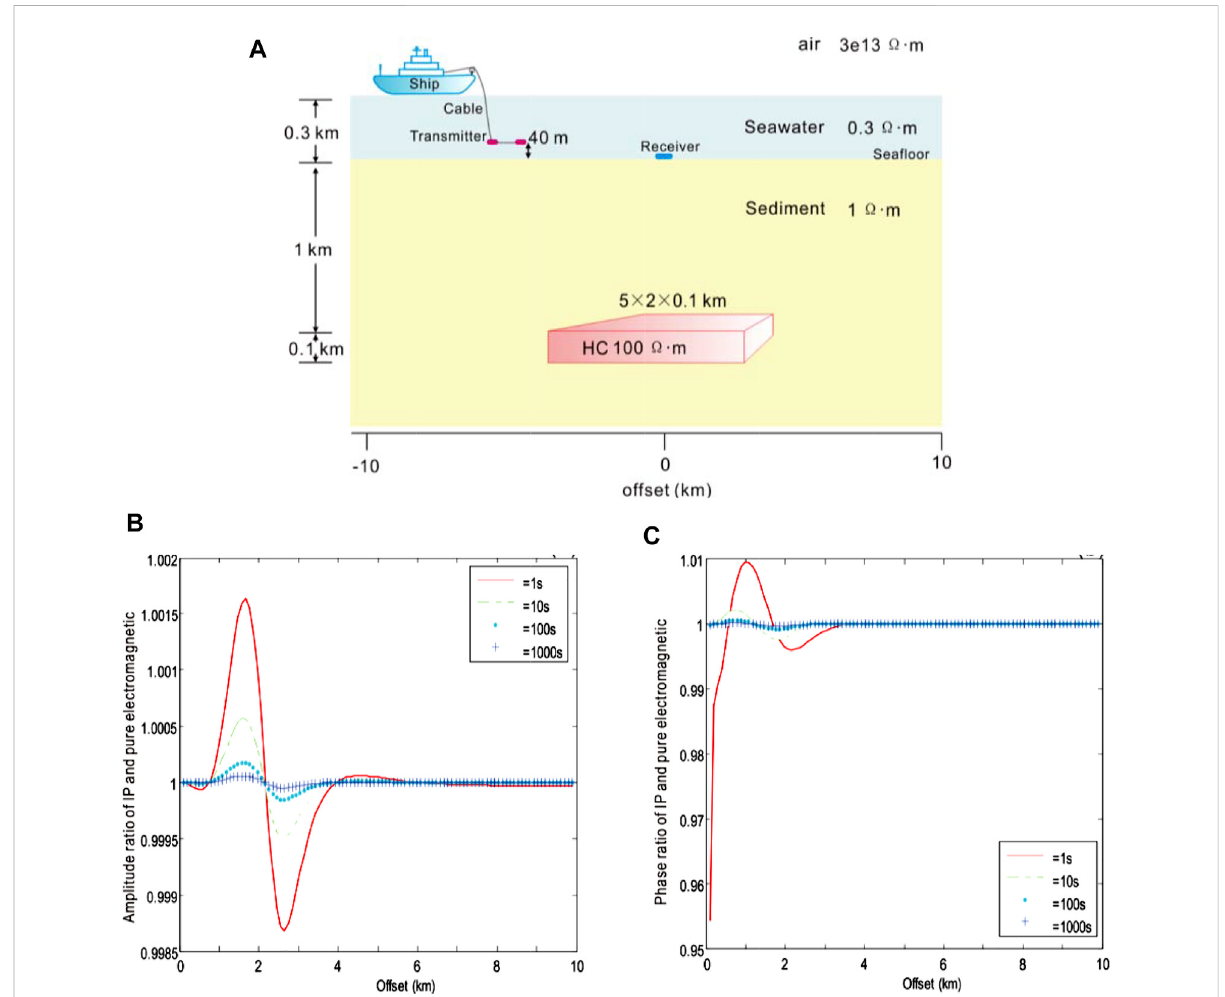
FIGURE 13 AmplitudeandphaseratioofCSEMwiththeIPandpureelectromagnetic fi eldtotheSNPmodelofvarioustimeconstants τ =1(red),10(green), 100 (blue), and 1,000 (light blue), respectively. (A) Geoelectric model of submarine hydrocarbons with ion-induced polarization in the 3D marine CSEM, (B) the ratio of amplitude, and (C) the ratio of